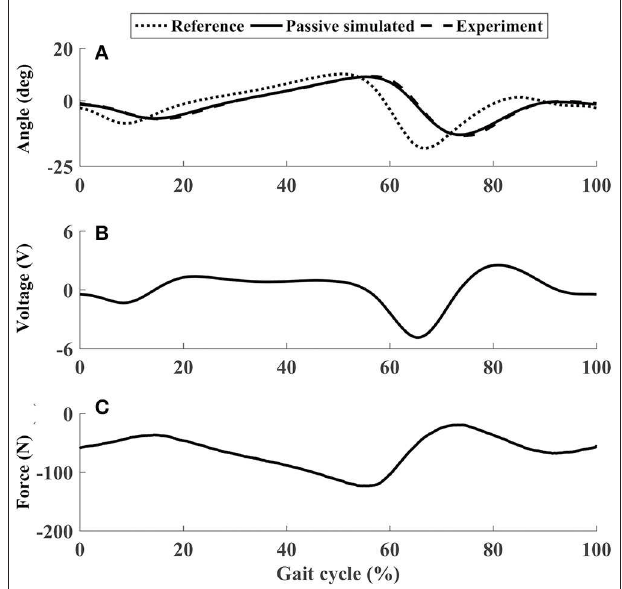
FIGURE 7 | The performance of P1 using the ankle mechanism in passive mode. (A) Ankle joint trajectories. (B) Input voltage. (C) Passive force. In (C) , negative values mean that the force sensor was